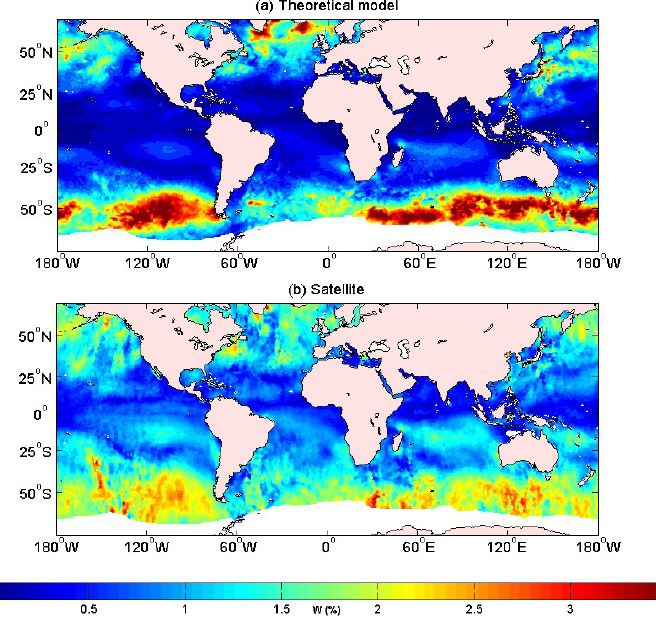
Figure 4. The whitecap coverage in October 2006 over 180° W–180° W,55° S–40° N, for ( a ) model results using Combination 36 ( θ = 11, ρ = 0.53) in Equation (3), and ( b ) satellite-derived results [20].